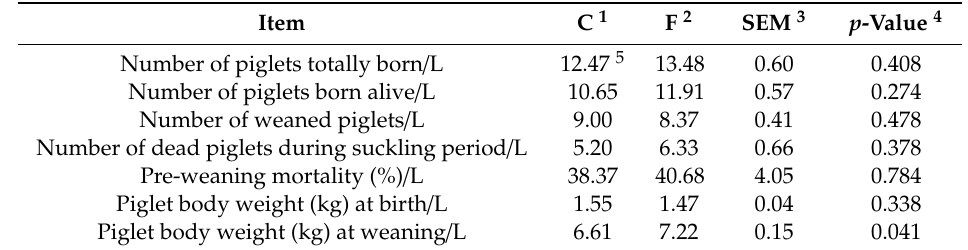
The litter performance traits of sows in response to Bacillus licheniformis -fermented product supplementation.